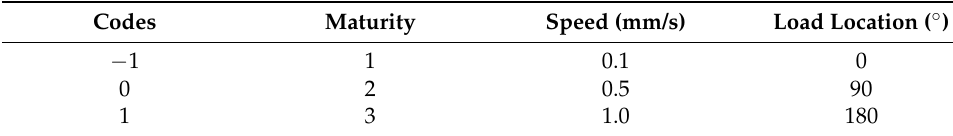
Table 3. Codes of the factors.